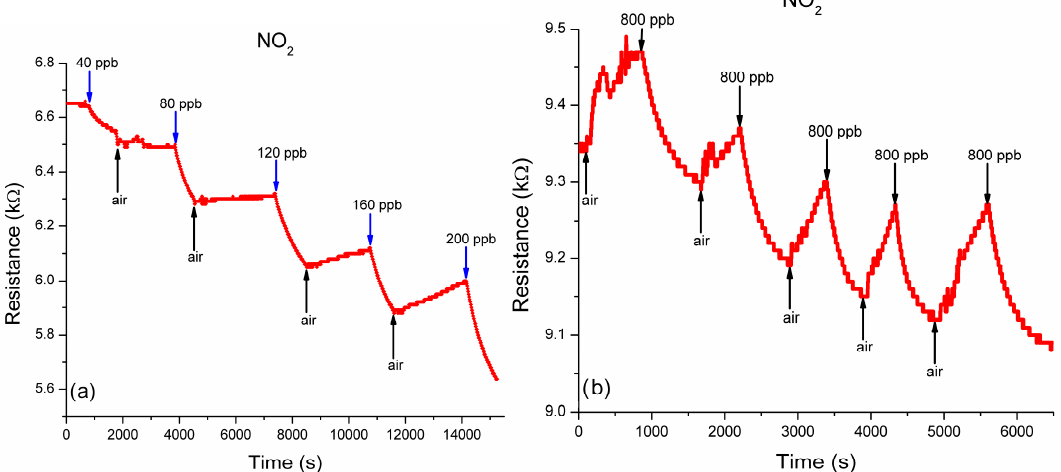
Figure 8. Figure 8. Cont.